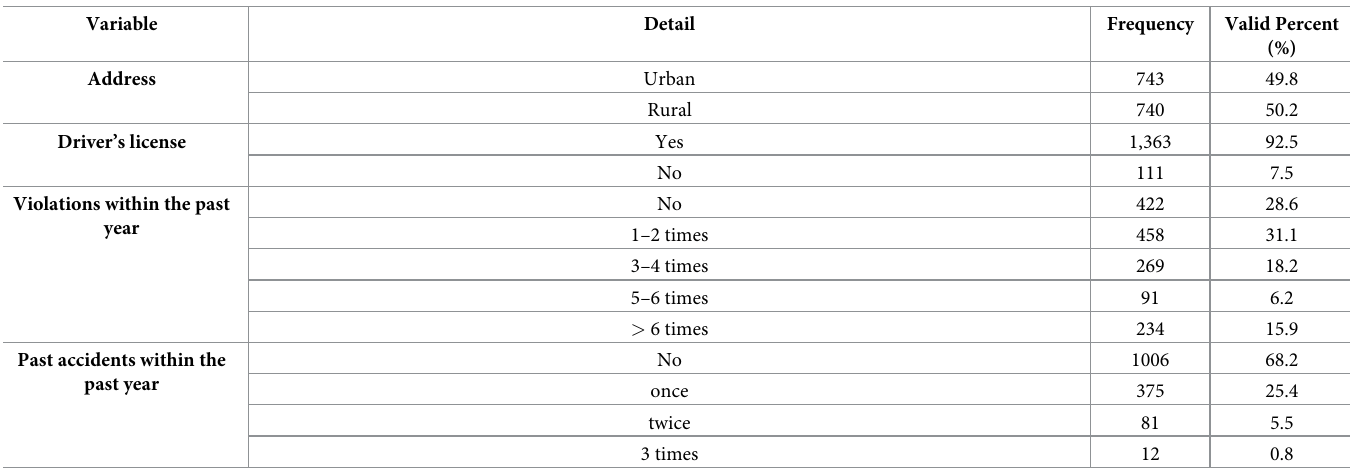
After data collection area was considered; the sample size will be indicated for this study. Samples were chosen countrywide, including 1,532 sample sets. A total of 1,474 sample sets could be used for analysis (Table 2), consisting of the central (12 districts with 303 samples), northern (19 districts with 257 samples), southern (12 districts with 300 samples), and north- eastern (14 districts with 308 samples) regions, as well as the Bangkok Metropolitan Area (14 districts with 306 samples), for a total of 76 districts with 1,474 samples.